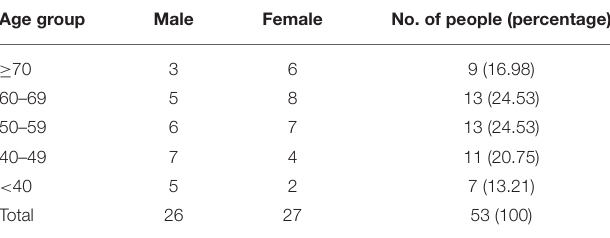
TABLE 1 | Demographic information of the